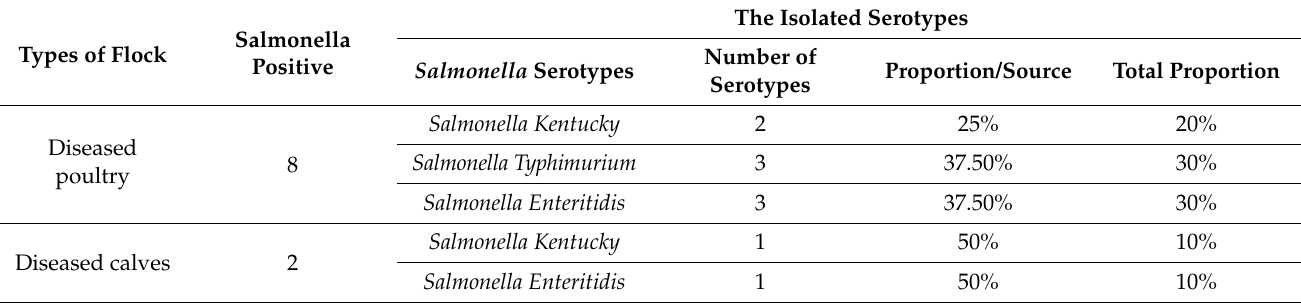
Table 5. The prevalence rates of isolated Salmonella serotypes from diseased poultry and calves.